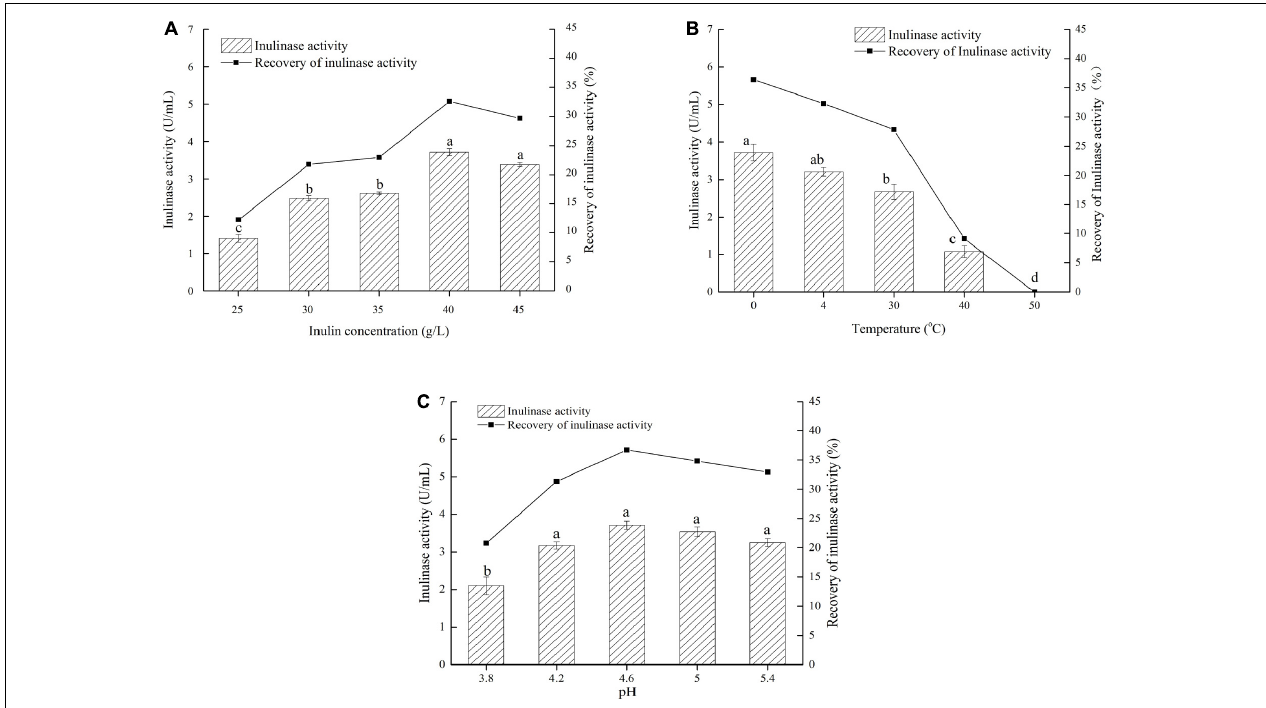
FIGURE 1 | Effects of inulin concentration, temperature and pH on the inulin-mediated ethanol precipitation of natural inulinase from Aspergillus niger. The conditions of the inulin-mediated ethanol precipitation were as follow: (A) 0 ◦ C, pH 4.0–5.0 and ethanol concentration of 55% (v/v); (B) 40 g/L inulin, pH 4.0–5.0 and ethanol concentration of 55% (v/v); (C) 40 g/L inulin, 0 ◦ C and ethanol concentration of 55% (v/v). Lower case letters: Significant differences ( p < 0.05). Statistical analysis was performed using a one-way ANOVA with Tukey’s test.